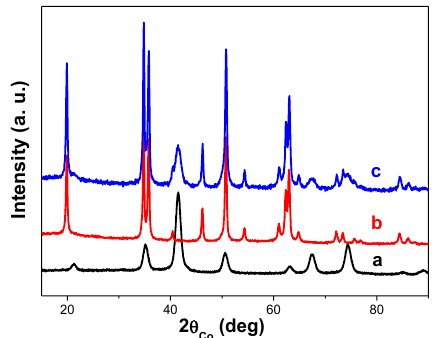
Figure 2. Powder X-ray diffraction ( PXRD) patterns of ( a ) γ-Fe 2 O 3 , ( b ) β-NaY 0.8 Eu 0.2 F 4 and ( c ) β-NaY 0.8 Eu 0.2 F 4 @γ-Fe 2 O 3 NPs. Table 1. Cell parameters, average crystal size and average micro-strain-induced lattice deformation, as inferred from Rietveld refinement. The average particle size inferred from transmission electron microscope (TEM) observation is given for information.